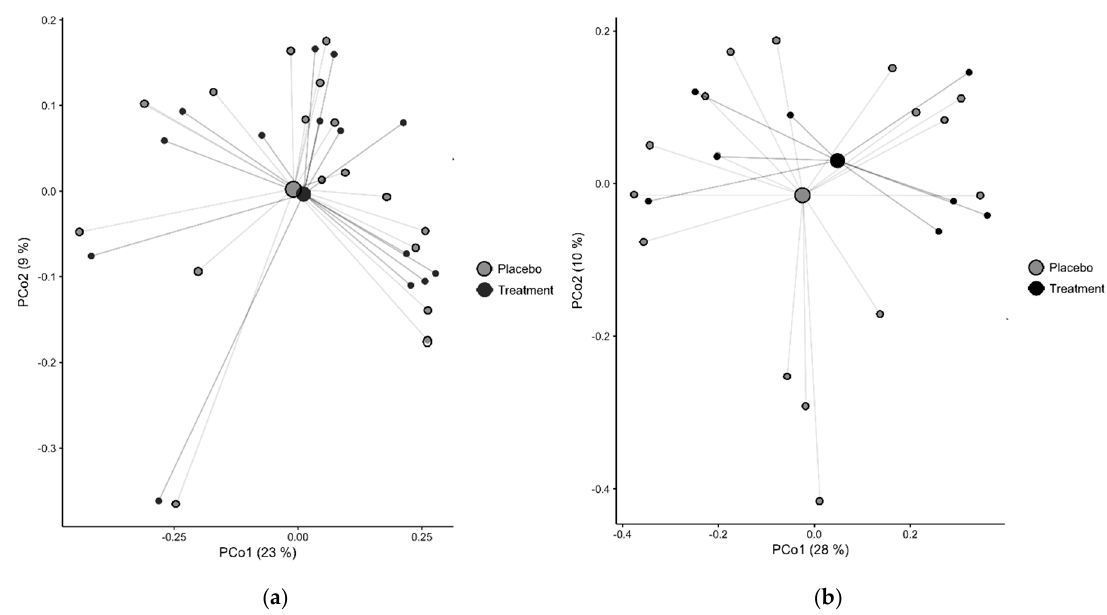
Figure 3. No significant treatment effects on microbiota was found in colonic biopsies (treatment n = 7, placebo n = 16) in principal component analyses at baseline ( a ) and week 16 ( b ).